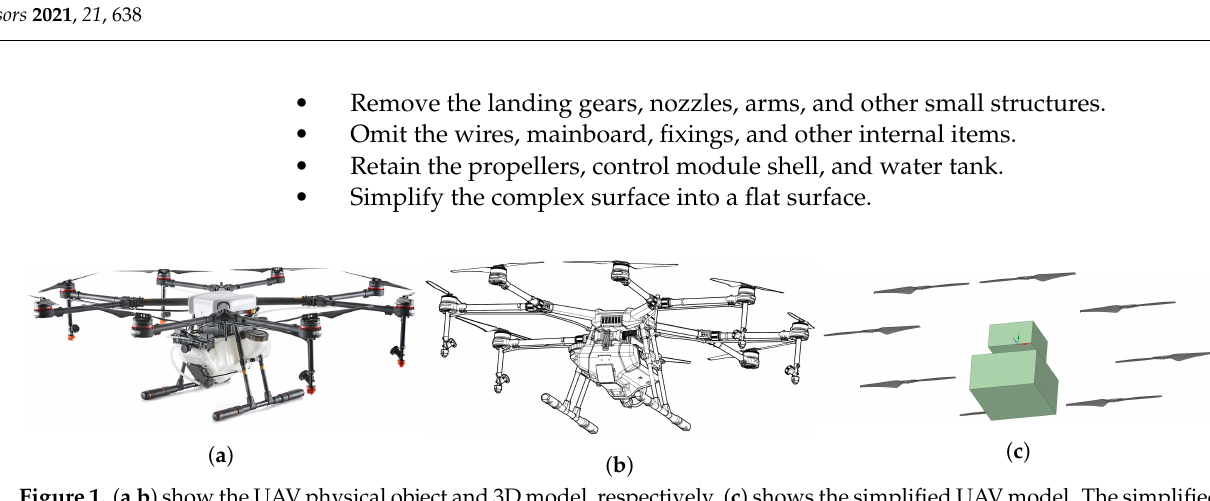
Figure 1. ( a , b ) show the UAV physical object and 3D model, respectively. ( c ) shows the simplified UAV model. The simplified UAV model consists of eight 2170 propellers, a control module shell, and a water tank.